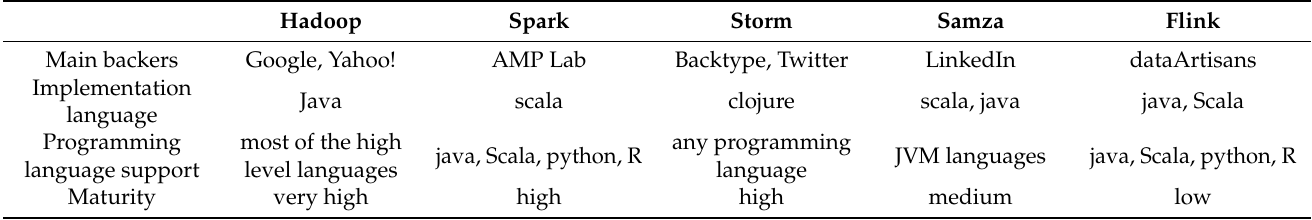
Table 3. Comparison of big data frameworks with respect to general